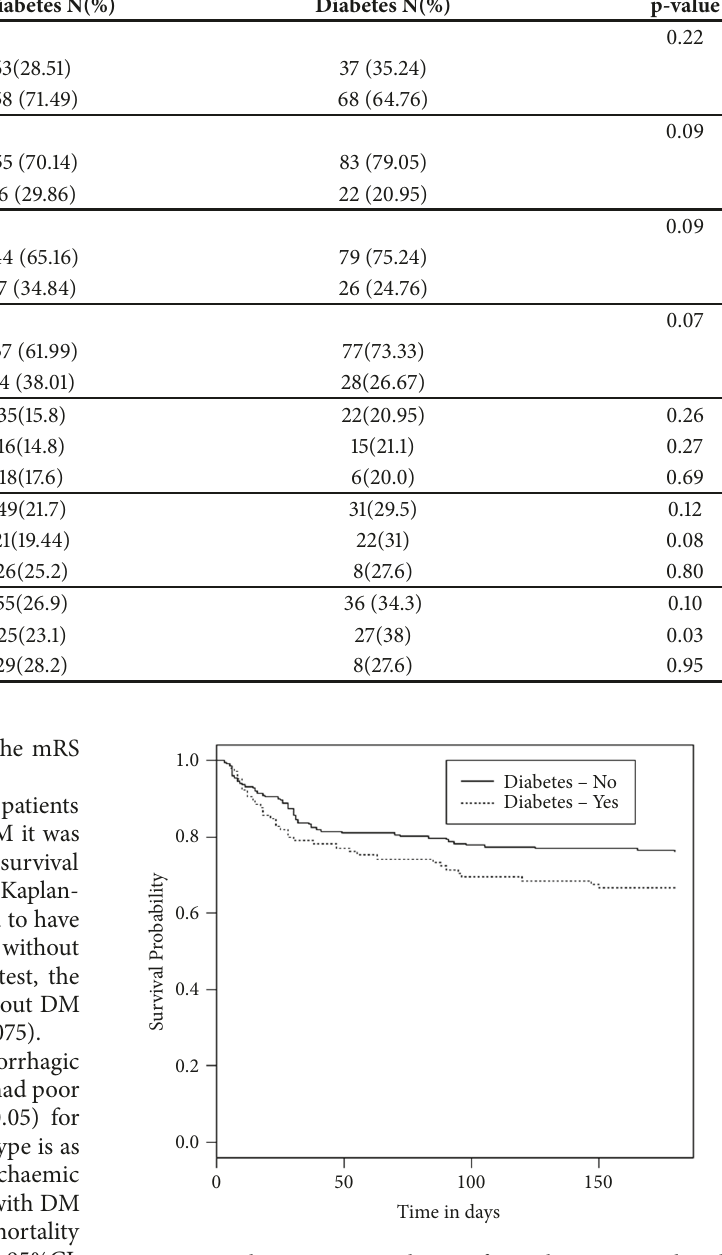
Figure 1: Kaplan-Meier survival curves for stroke patients with and without